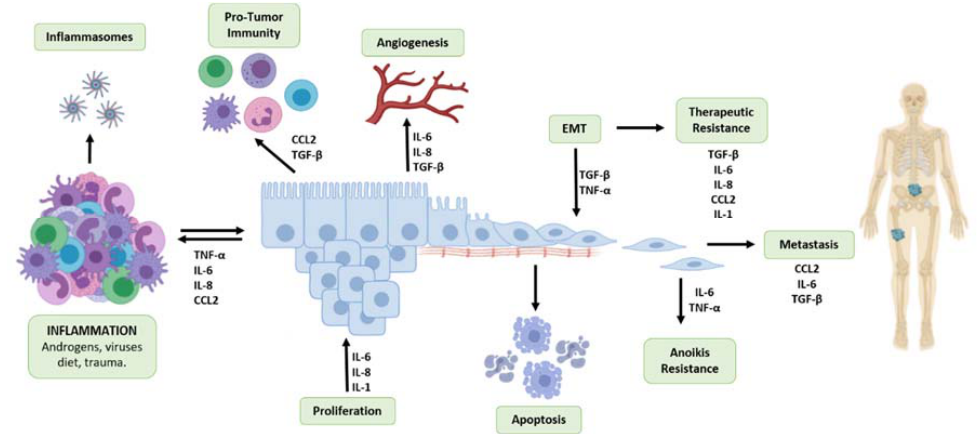
Figure 2. Overlapping functions of Inflammatory Cytokines Determine the Prostate Tumor Microenvironment Landscape and Metastatic Progression. Systemic and local inflammation in the prostate as a result of androgens, viral infections, trauma and diet is characterized by production of pro-inflammatory cytokines. In the microenvironment of primary prostate tumors, inflammation is sustained by production of pro-inflammatory cytokines by caner epithelial cells. These cytokines promote tumor cell proliferation, act as chemoattractants for tumor-associated macrophages (TAMs) and other immune cells to promote immune evasion, angiogenesis and ultimately tumor cell invasion and progression to metastasis to the bone. transforming growth factor beta (TGF- β ) and tumor necrosis-factor- α (TNF- α ) mediate the phenotypic reprogramming of tumor cells via Epithelial–Mesenchymal Transition (EMT) allowing the cells to lose their tight junctions and promote anoikis with consequential loss of attachment to basement membrane. This phenotypic reprogramming, along with influence of inflammatory cytokines confers resistance to therapeutics, via impacting cell survival as tumor cells are subjected to apoptosis; NF- κ B signaling facilitates resistance to anoikis in tumor cells empowering migration, invasion and development of metastatic lesions primarily in the bone with the functional contributions by chemokine ligand 2 (CCL2), IL-6, and TGF- β within the bone